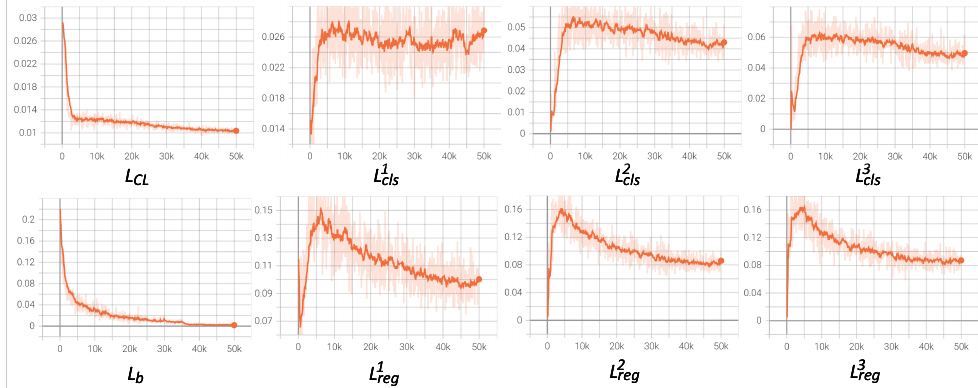
Figure 5. Training loss.